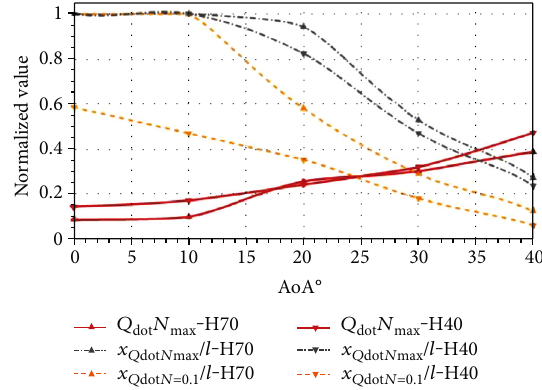
Figure 18: Plots of key indicators against angle of attack for the H70Ma20 and H40Ma5